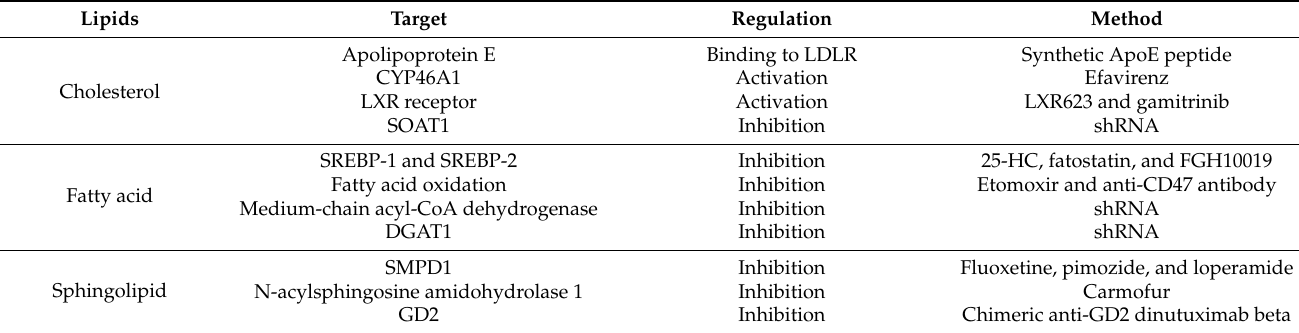
Table 1. Therapeutic strategies targeting lipid metabolism in